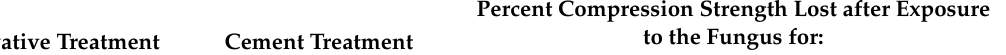
Table 4. Comparative decay resistance of untreated and preservative-treated pine wafers with and without cement infusion and exposed to Fibroporia radiculosa in a soil block decay test. Each value is the average of eight replicates, with high values representing extensive